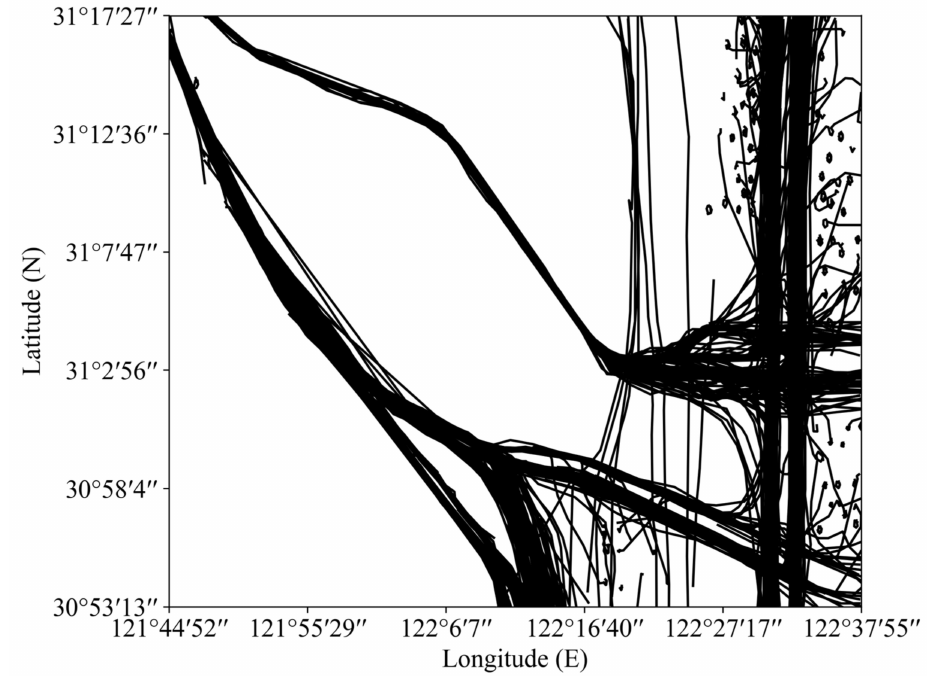
Figure 5. The initial ship trajectories in study waters.